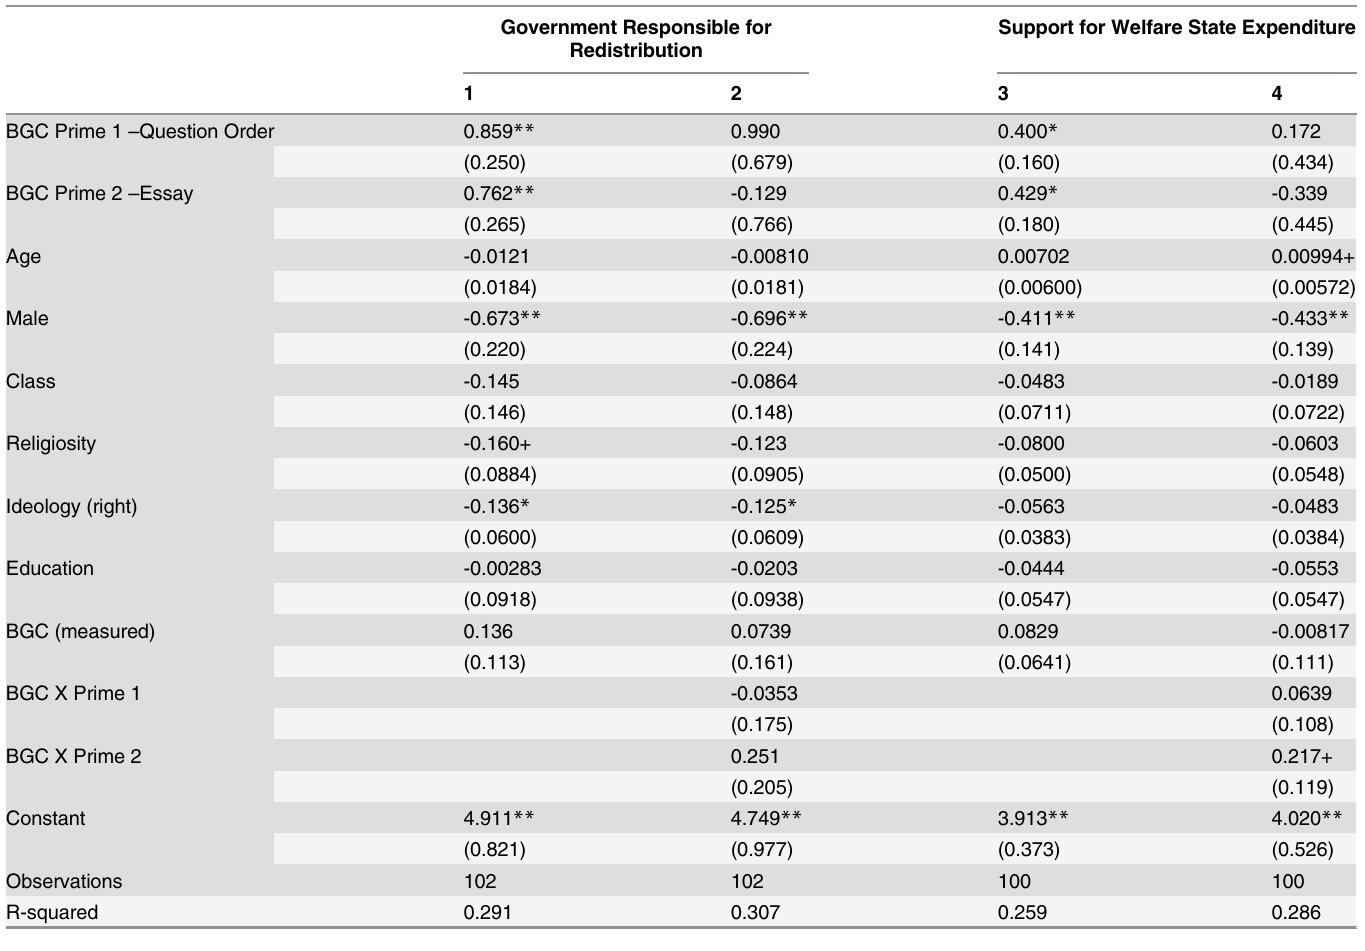
Table 2. Effect of BGC on WSA among Israeli Jews (Study